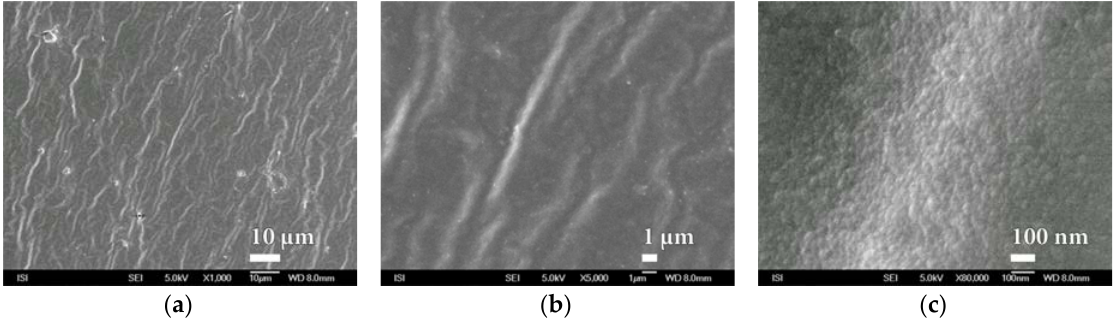
Figure 16. SEM micrographs of SiO x barrier nanocoating surface prepared by plasma deposition by HMDSO method on the PP foil at magnification of ( a ) 1000×, ( b ) 5000× and ( c ) 80,000×.